Question: Write a single sentence explaining what this figure depicts.
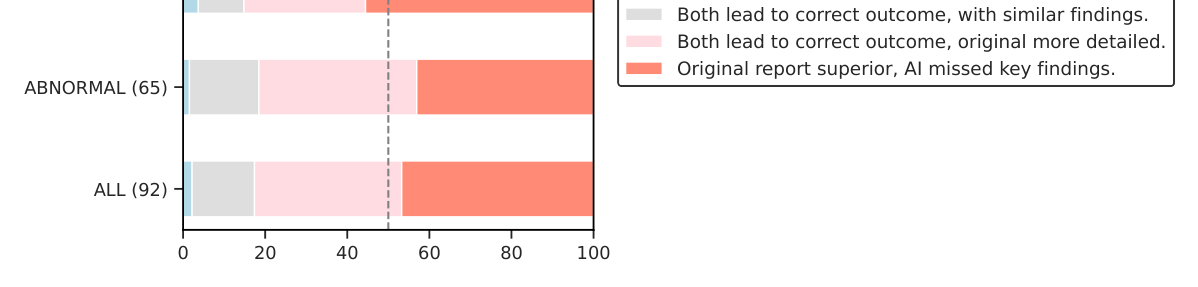
Answer: | Med-Gemini-3D Head CT report generation scores on a subset of 92 cases from the CT-US1 test set scored by a US-based board certified radiologist. Across all cases, 17% of the AI generated reports were graded equivalent or superior to that of radiologists’ reports, while 53% were judged as resulting in equivalent patient care. Performance was better overall on abnormal versus normal cases.